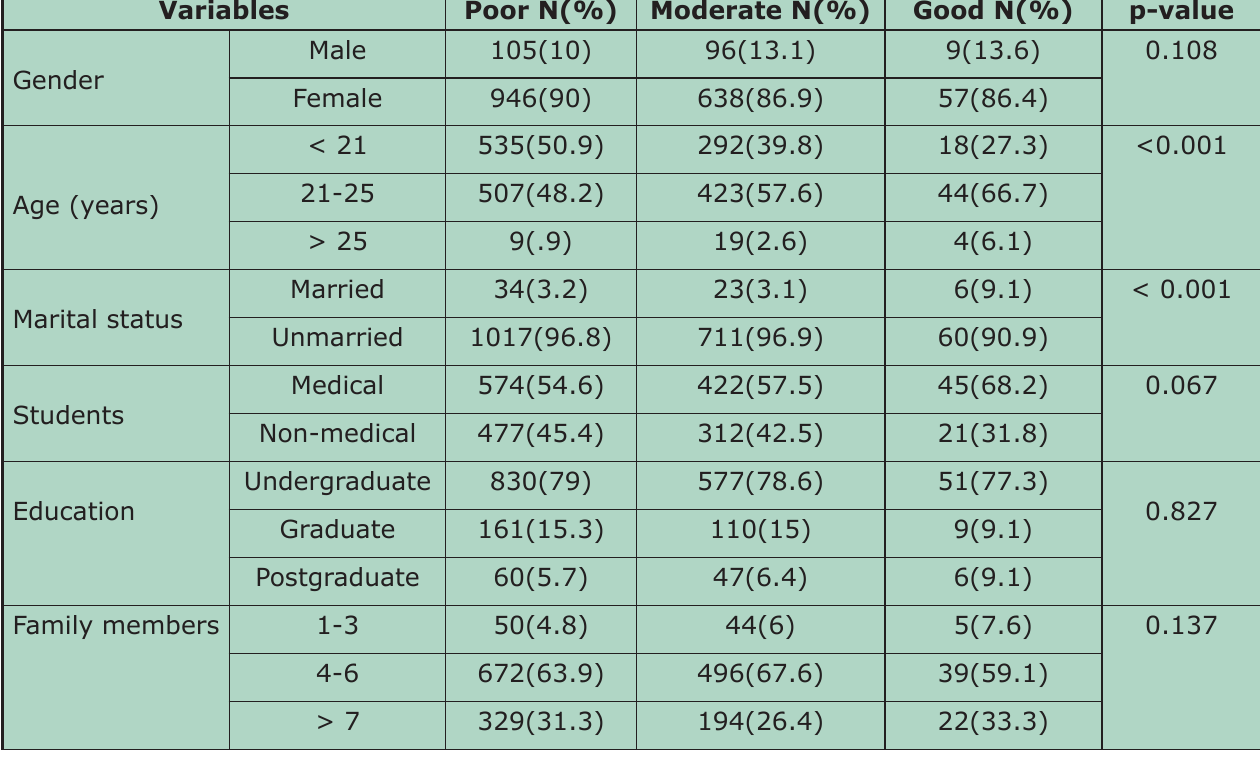
Table-I: Comparison of general demographic characteristics of all the students with COVID-19 knowledge